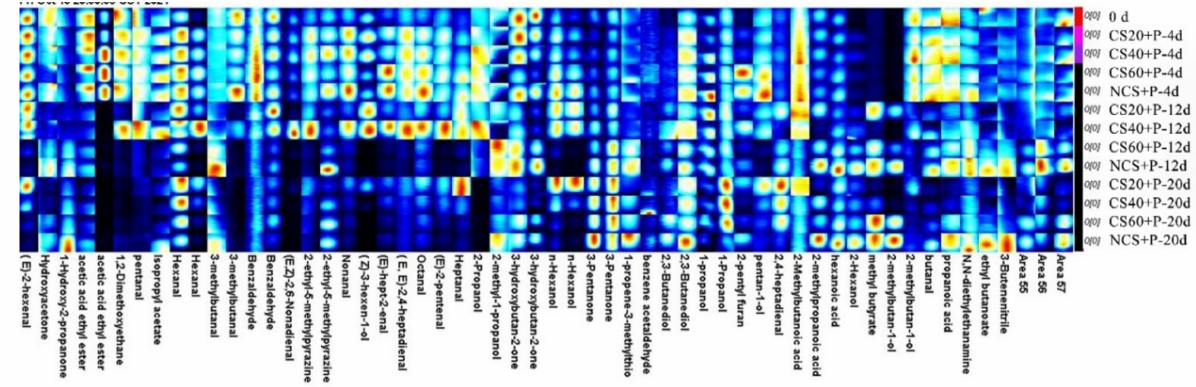
Figure 8. Fingerprints of volatile organic compounds in cucumbers under different treatments. The color depth represents the concentrations of the volatile compounds. Red indicates that the concentration of the substance is high, while blue indicates that the concentration of the substance is low. CS20+P − packaged after 20 min of cold shock; CS40+P − packaged after 40 min of cold shock; CS60+P − packaged after 60 min of cold shock; NCS+P − packaged after 0 min of cold